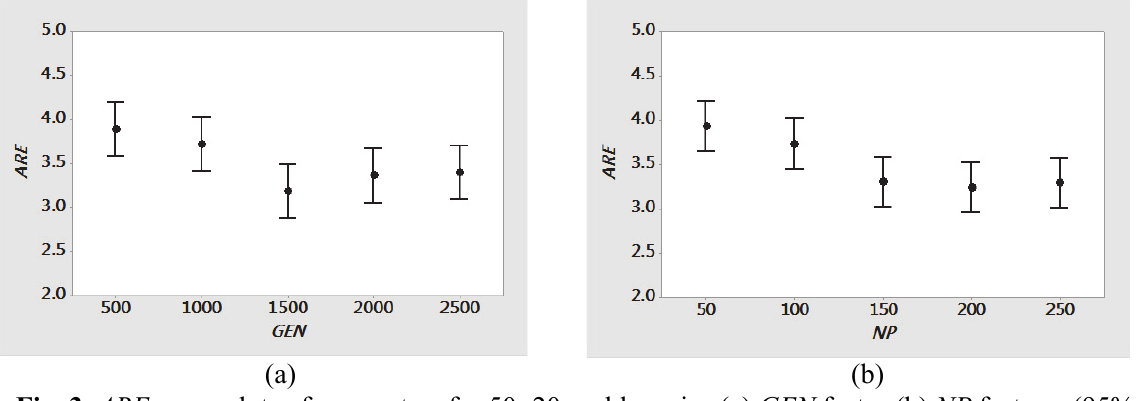
Fig. 3. ARE mean plots of parameters for 50×20 problem size (a) GEN factor (b) NP factor